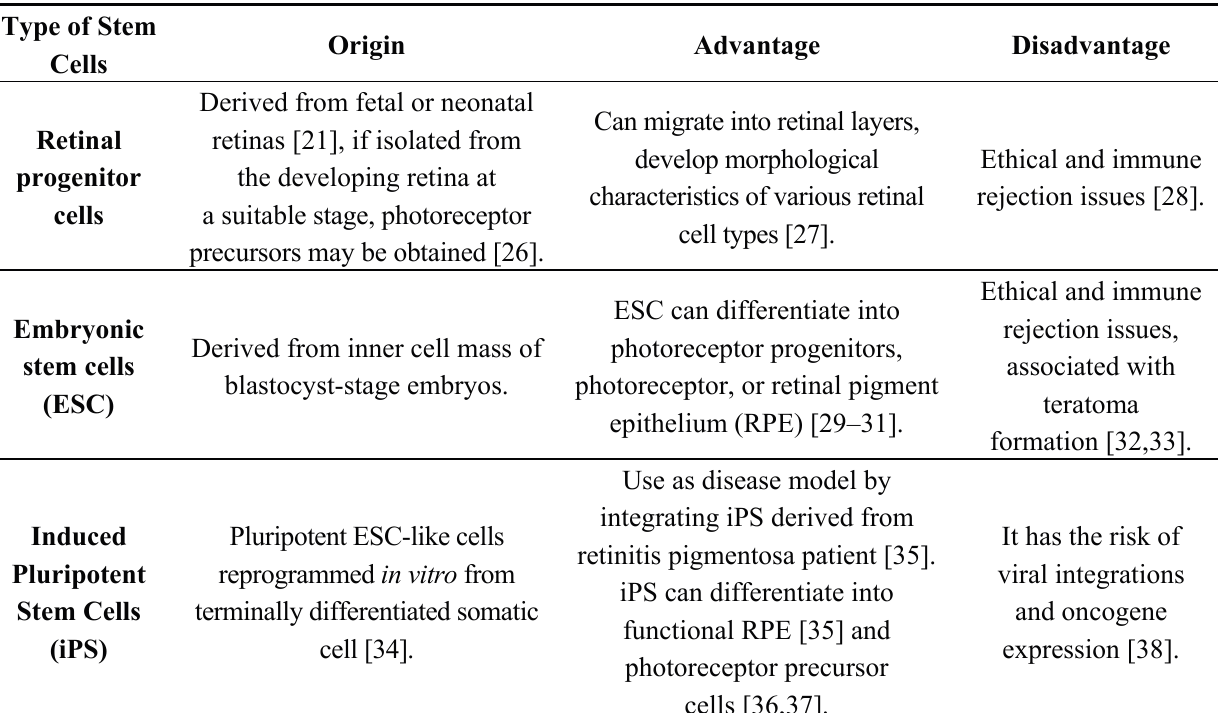
Table 1. Comparison of other source of stem cells used for stem cell therapy in degenerative retinopathies